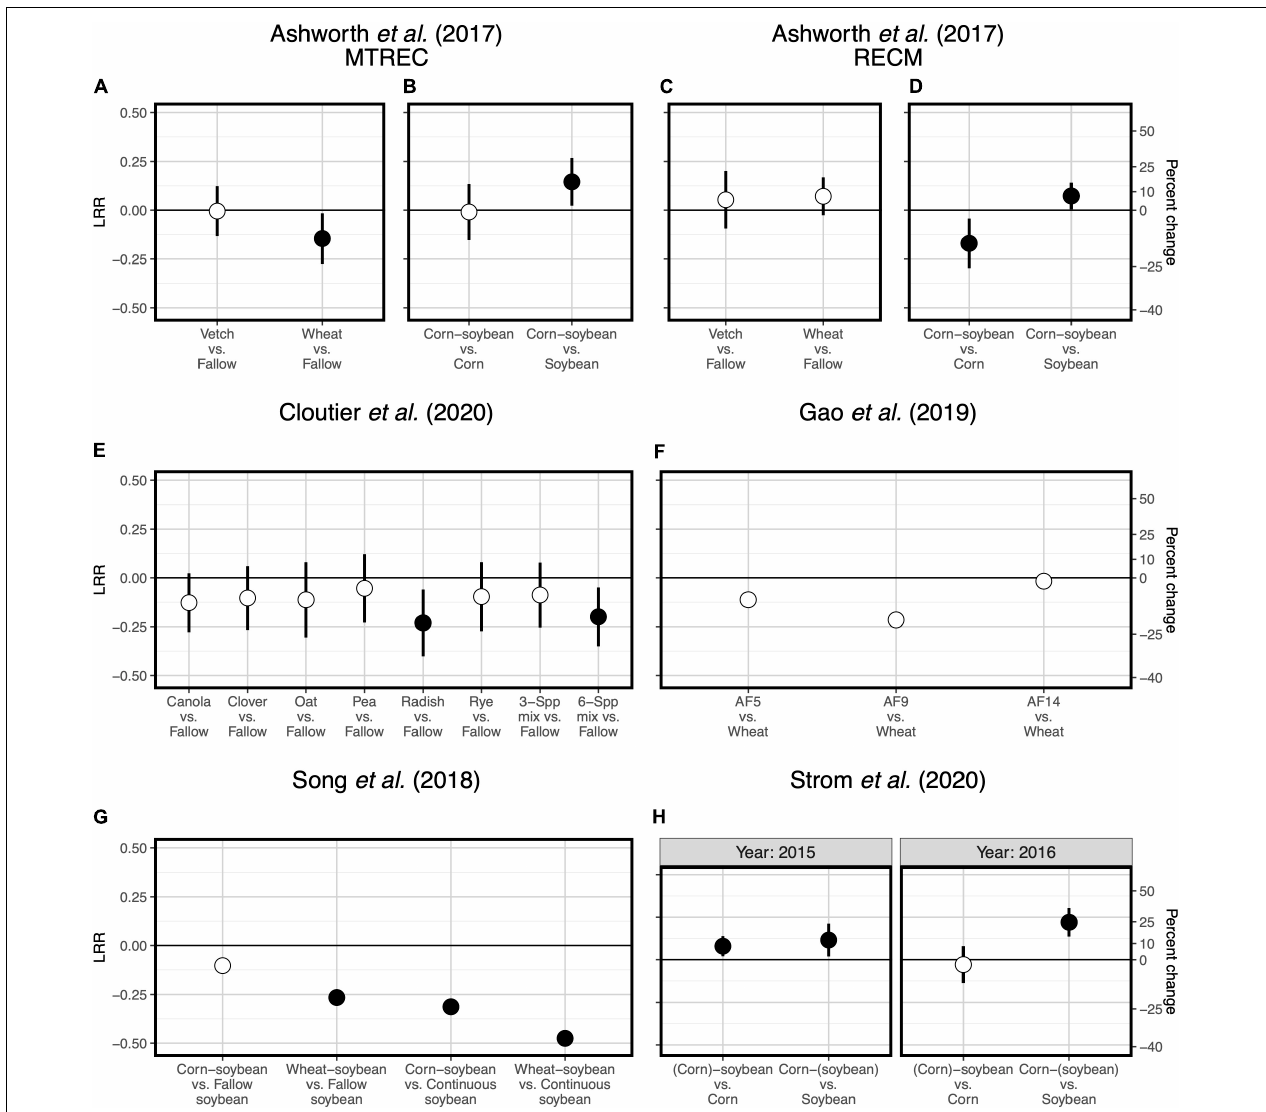
FIGURE 2 | Responses of soil organic carbon to crop diversification. Five studies are represented: Ashworth et al. (2017) (A–D) , Cloutier et al. (2020) (E) , Gao et al. (2019) (F) , Song et al. (2018) (G) , and Strom et al. (2020) (H) . Responses are shown as log response ratios (LRR) with 95% confidence intervals which account for low sample sizes (Pustejovsky, 2018). Open points represent log response ratios whose 95% confidence intervals overlap zero, while solid points represent log response ratios whose 95% confidence intervals do not overlap zero. Responses in (F,G) do not have 95% confidence intervals because the original studies reported only treatment mean organic carbon values rather than plot-level values; solid points represent cases in which the original study found